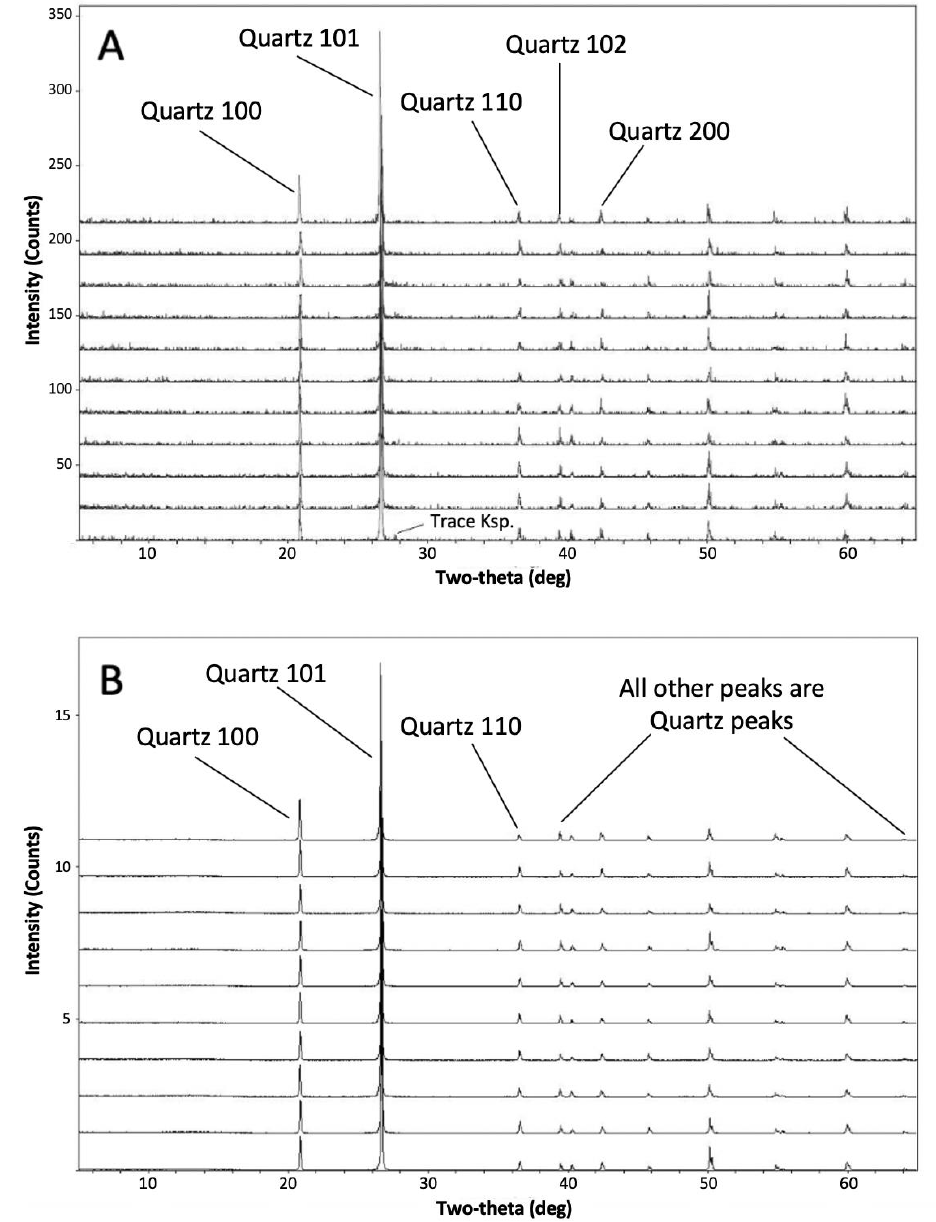
Figure 2. Powder X-ray diffraction patterns of samples 1 – 10B, showing only diffraction peaks for quartz. Major lines are labelled. Sample 1B, exhibited a trace peak for potassium feldspar, at approximately 3.24, consistent with microcline and other feldspars [35]. Minor K-feldspar peaks are present near detection level in some patterns.